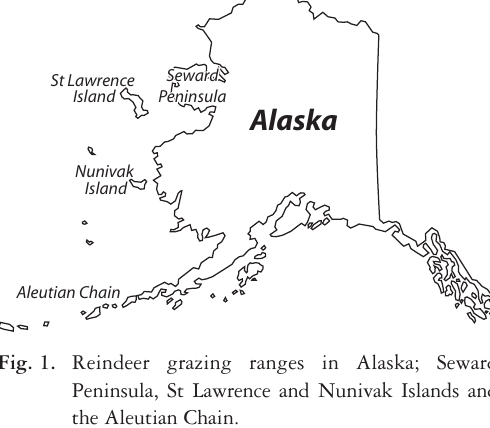
Fig. 1. Reindeer grazing ranges in Alaska; Seward Peninsula, St Lawrence and Nunivak Islands and the Aleutian